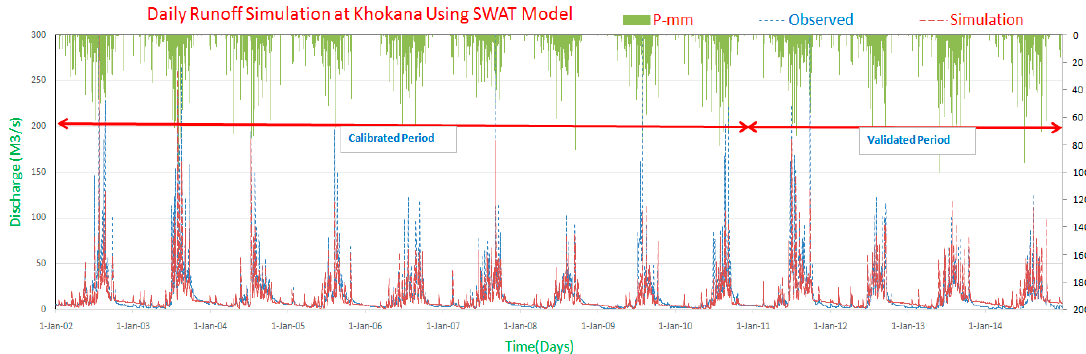
Figure 4. Daily observed and simulated discharge at Khokana station, Kathmandu Valley watershed.